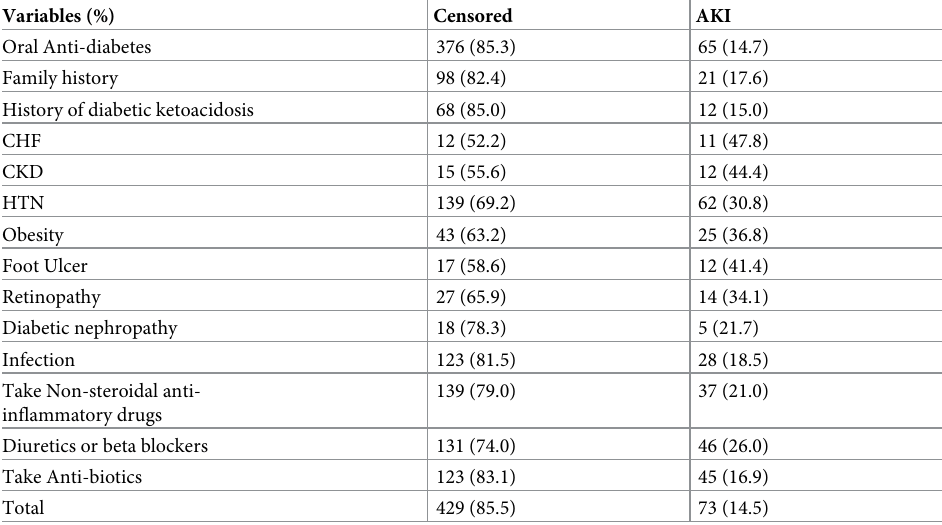
Table 2. Comorbidity among T2D patients at government hospitals in East Ethiopia from 2013 to